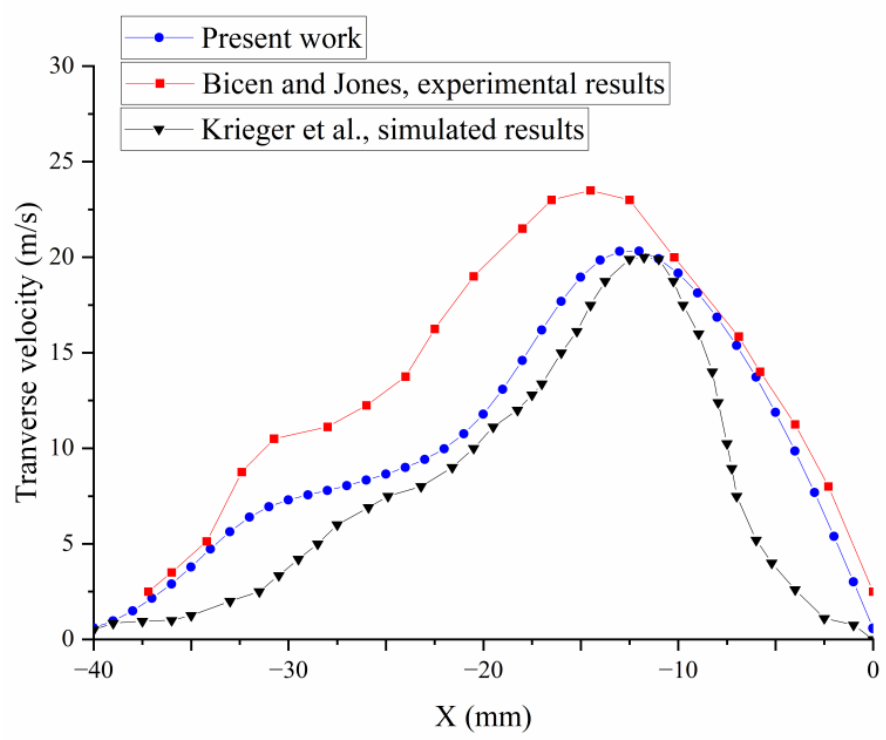
Figure 2. Validation of the numerical model with experimental data.